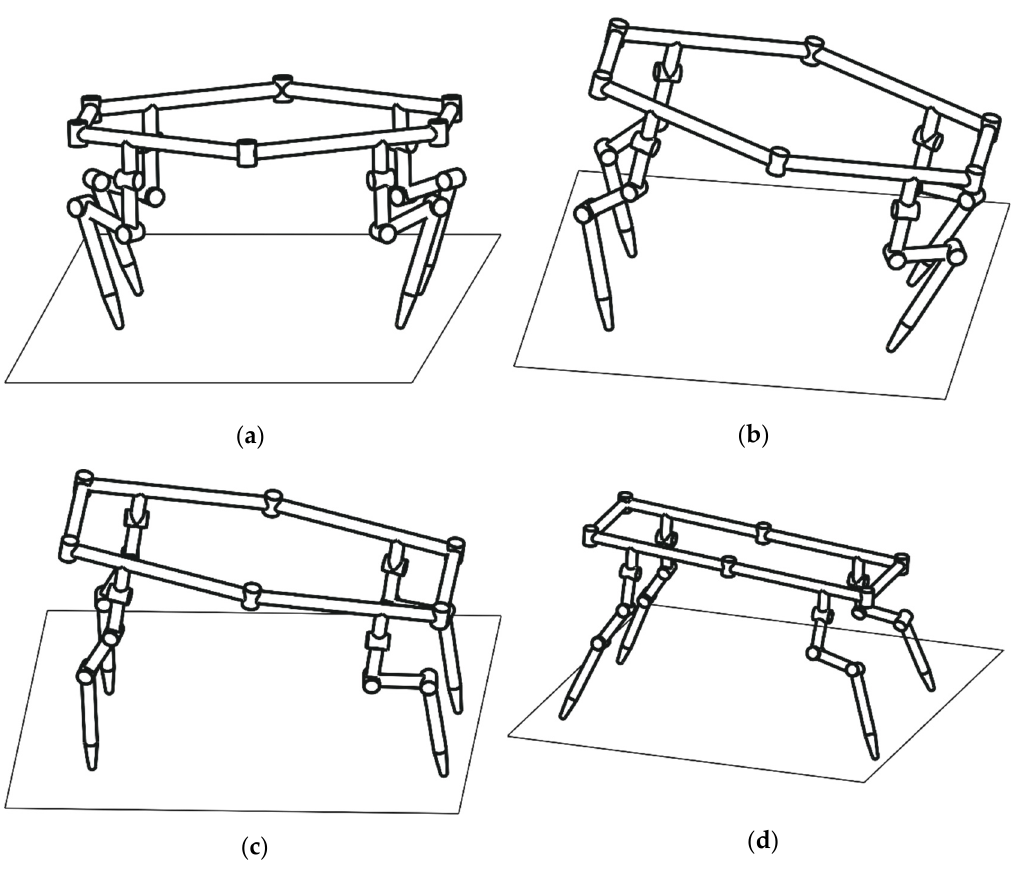
Figure 3. Imitate a jumping motion of the frog. ( a ) The trunk and legs contract. The robot prepares to jump; ( b ) The trunk stays contracting. And the fore legs lift up; ( c ) The trunk expands. The hind legs pull to the ground; ( d ) The trunk completely expands. The robot jumps out eventually. Stage (a): The Origaker II contracts its trunk and legs. The expandable angle θ turns to 60 the preparation stage of the